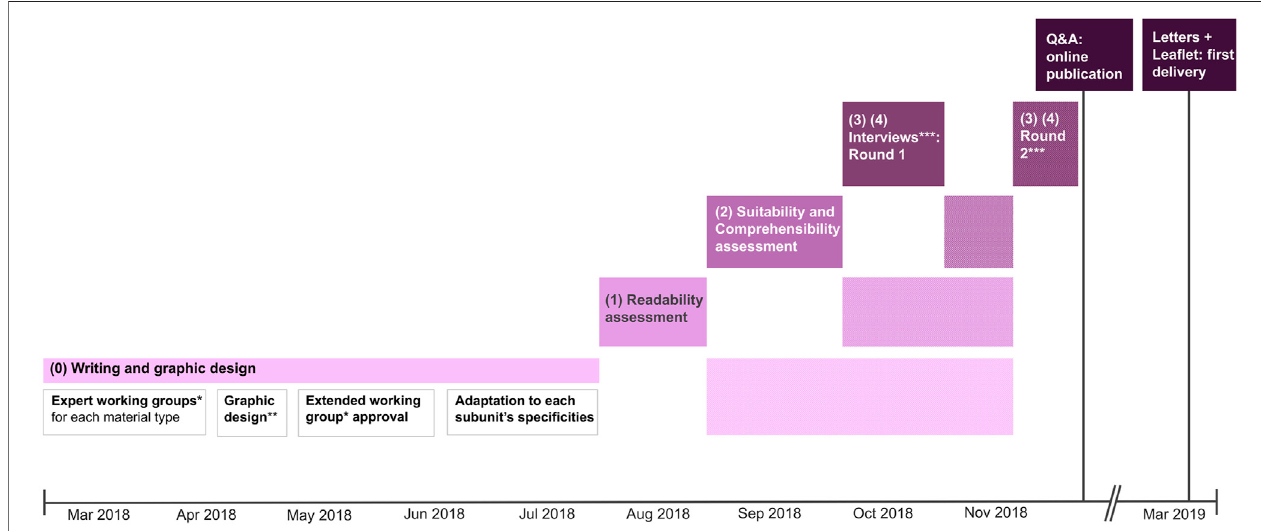
FIGURE 1 | Timeline and procedures involved in the development of information materials. *Professionals involved in the fi rst drafts included Public Health physicians,healthvisitors,specializednursesandspecializedhealthclerksbelongingtotheAgency ’ sScreeningUnit.**Graphiclayoutwasdesignedincollaborationwith experts from the Agency ’ s Communication Unit. ***The interviews were conducted by trained Public Health physicians and medical residents (FD, DC, LC, NP and JB). Re-assessments on subsequent versions of the materials are depicted in the textured bars.